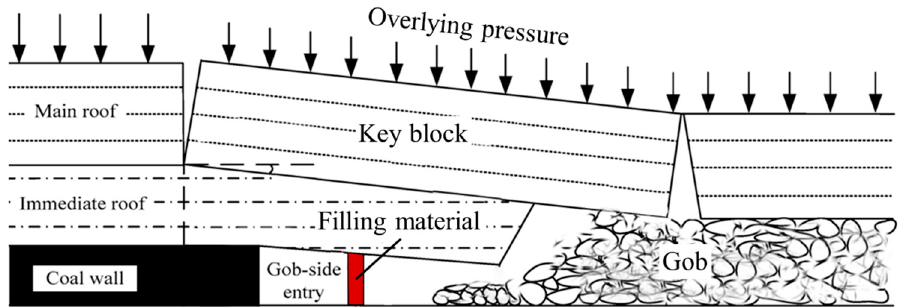
Figure 1. Diagram of material filling for gob-side entry retaining (MFGER).